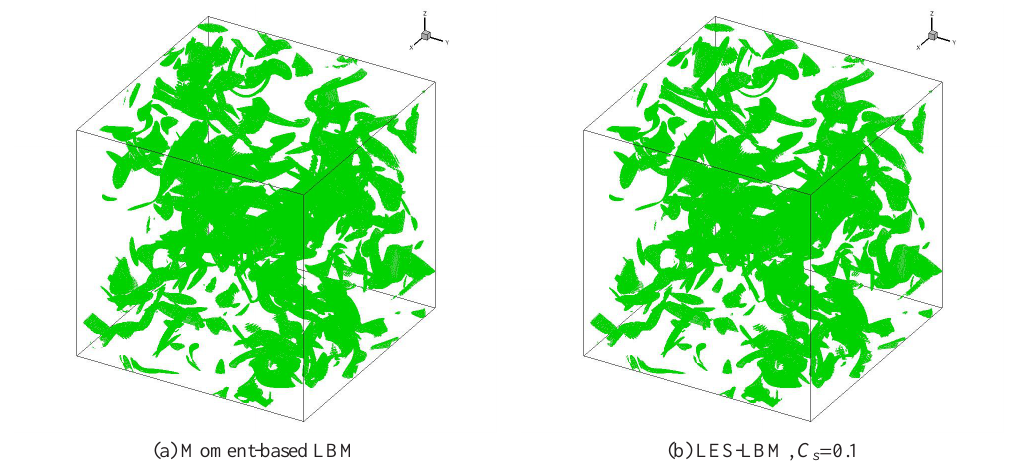
Fig. 12 Vorticity magnitude ω comparison for Re λ = 314 at t = 1.